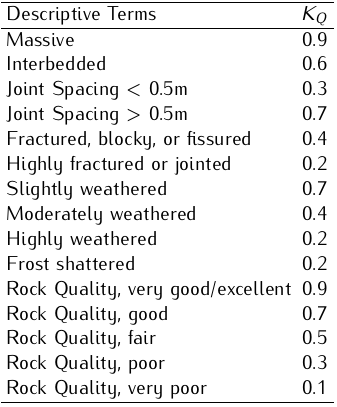
Table 2. Descriptive terms for rock quality, K